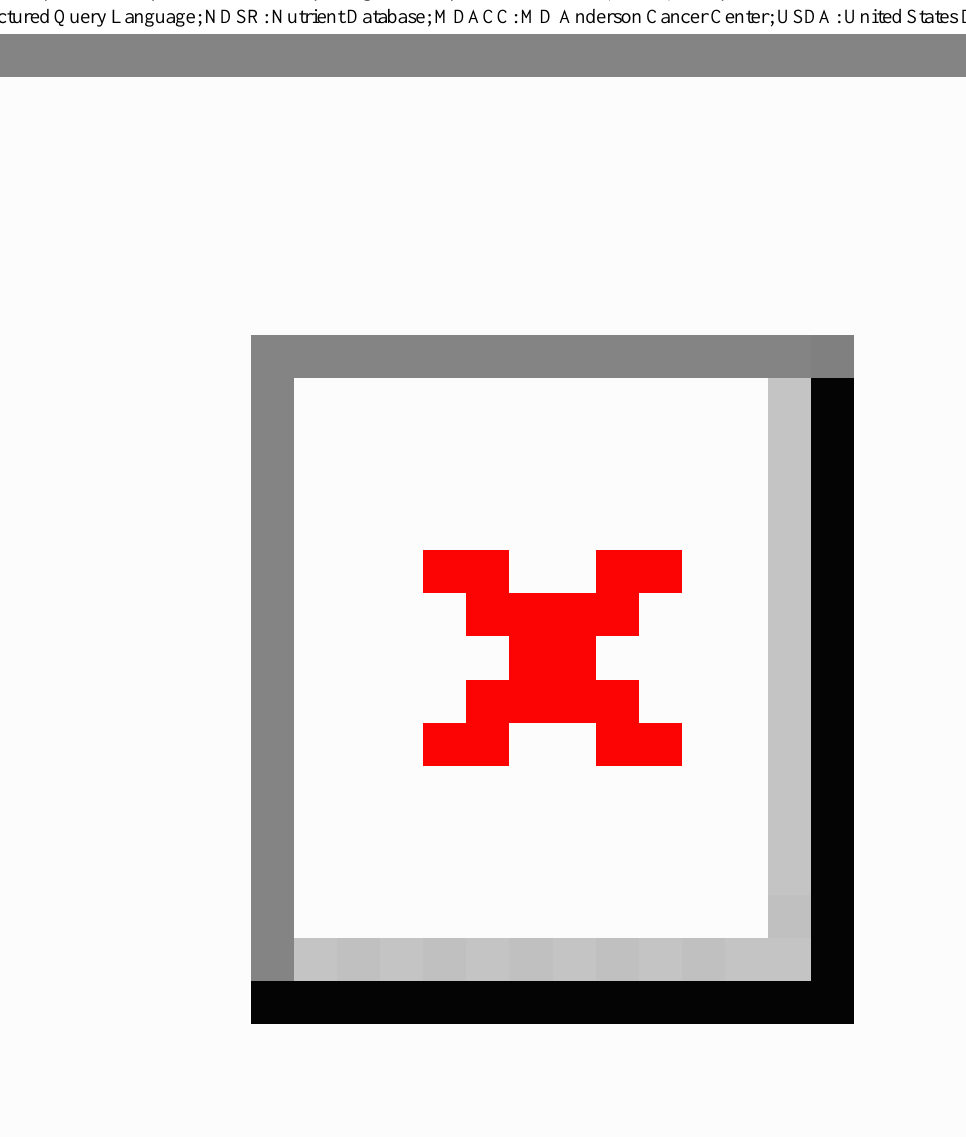
Figure 1. Recipe inclusion process: scheme depicting how recipes were collected, tested, and uploaded into the "@TheTable" database.